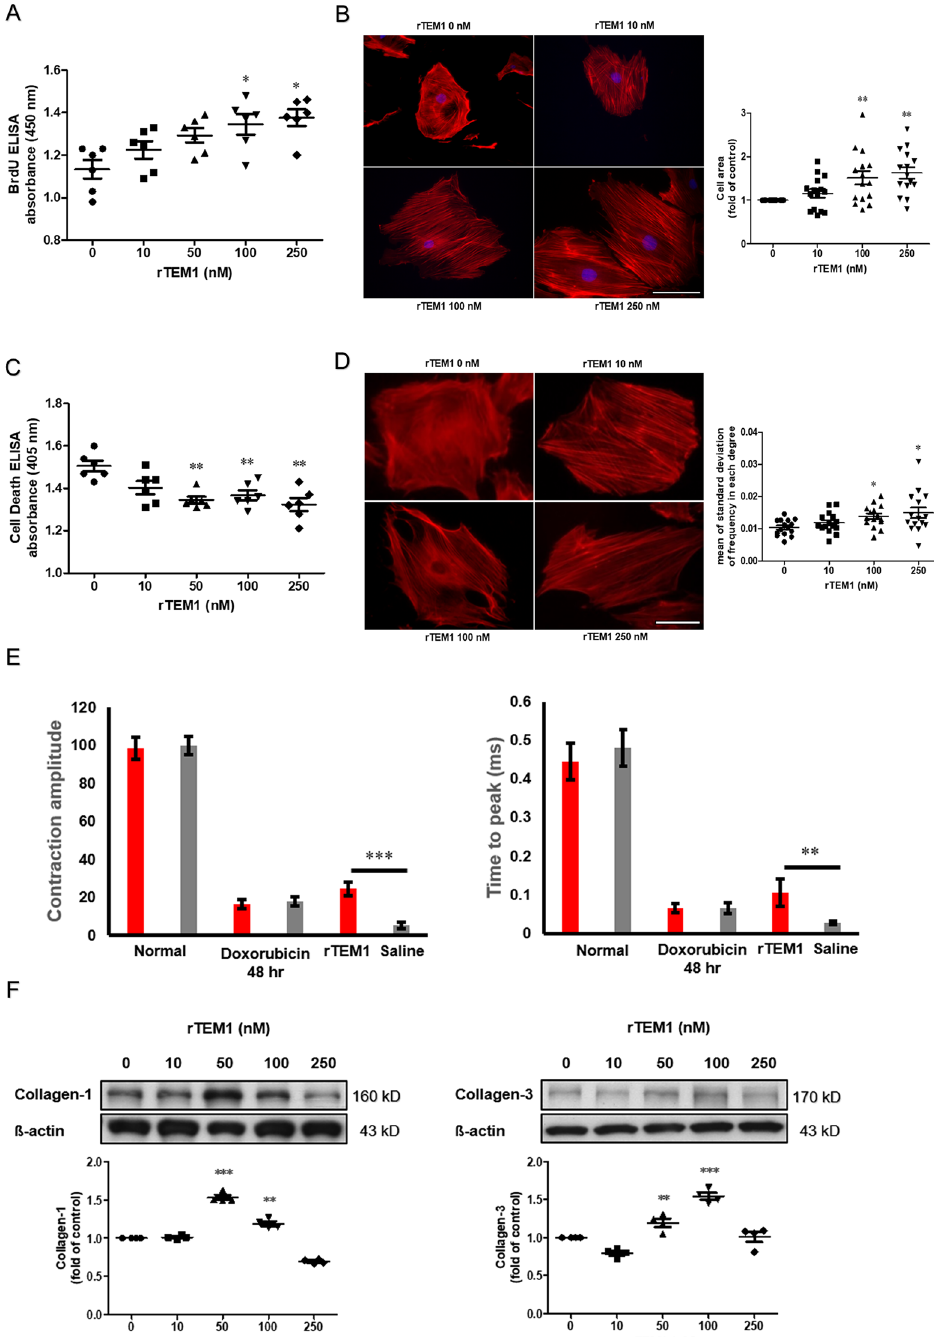
Figure 4. TEM1 affected cell behaviors ( A ) Cell proliferation was evaluated by measuring BrdU incorporation with ELISA during DNA synthesis as the cells replicate (n = 6). The data were presented as absolute values of absorbance. *p < 0.05 compared to control group adding saline. ( B ) Cell area was measured and expressed as a ratio of rTEM1-to saline-treated cells (15 cells were measured after each treatment). **p < 0.01 compared to control group with saline treatment. Scale bar = 100 mm. ( C ) Cell apoptosis was measured by quantifying oligonucleosomes cleaved from double-stranded DNA with ELISA during cell apoptosis (n = 6). The data were presented as absolute values of absorbance. *p < 0.05; **p < 0.01 compared to control group adding saline. ( D ) Representative pictures showed more uniform orientation of actin filaments after rTEM1 treatment (15 cells were measured after each treatment). Scale bar = 100 mm. Images of actin filament were analyzed by Fast Fourier Transform and standard deviations of actin filament direction were calculated. *p < 0.05 between comparisons. ( E ) Contraction amplitude and velocity of the hESC-derived contractile cardiomyocytes were measured after indicated treatment (n = 4). **p < 0.01 and ***p < 0.001 compared to control group with adding saline. ( F ) Collagen-1 and collagen-3 were evaluated with western blot. The expression levels were expressed as a ratio to normal without adding rTEM1 (n = 4). **p < 0.01 and ***p < 0.001 compared to normal. Original images of western blot were provided in “Supplemental